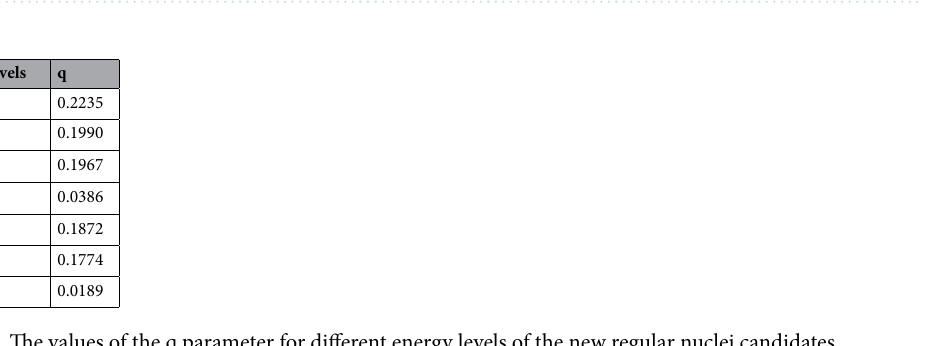
Figure 8. Similar to Fig. 1, the statistical distribution of 4 + γ energy level.